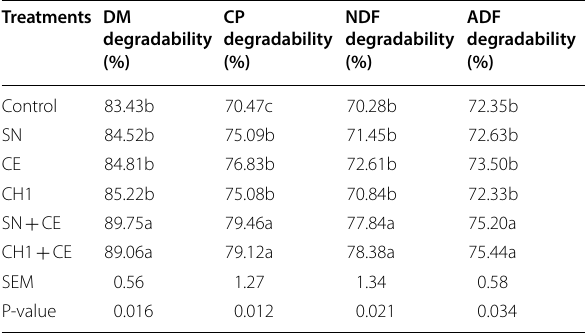
CH1, L. plantarum ; SN, L. Rhamnosus ; CE, cellulase enzyme; SN plantarum detergent fiber, SEM standard error of means Means within the same column with different letters are significantly different (P <